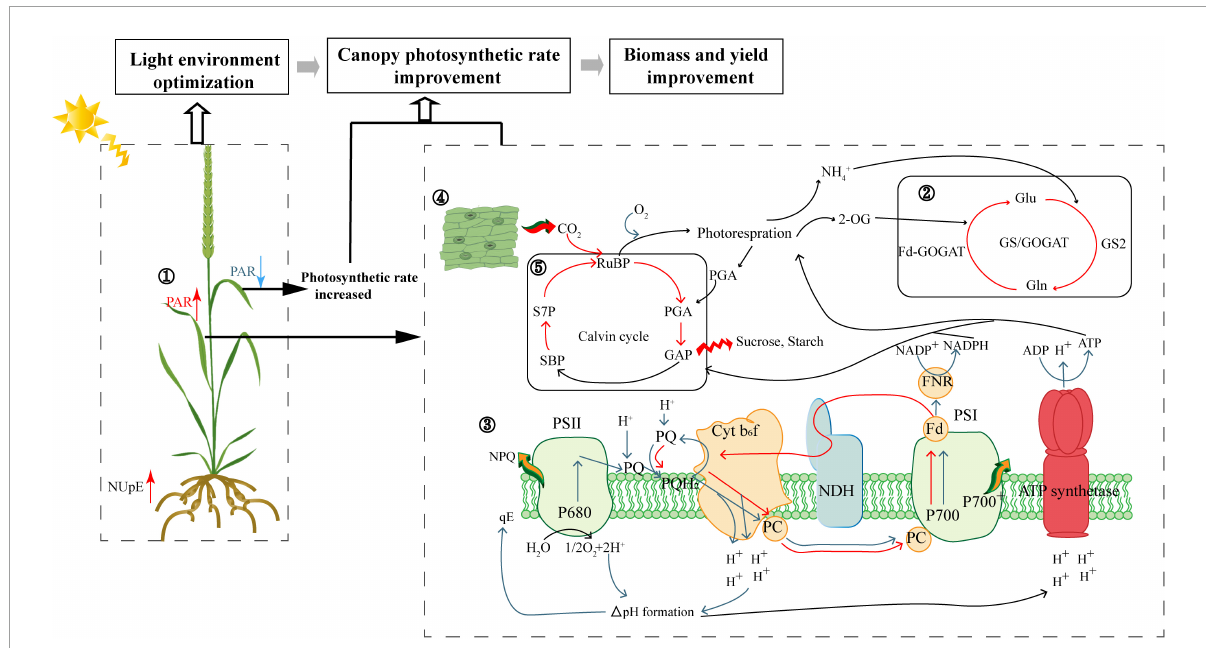
FIGURE9 The proposed model for the molecular mechanism by which optimized canopy light distribution (CLD) enhances light use efficiency. Optimized CLD increases the leaf nitrogen concentration and changes the leaf nitrogen allocation. The light allocation of penultimate leaves between photosystems was optimized by decreasing the abundance of photosystem II (PS?) light-harvesting proteins and the variety of PSII subunits and increasing the abundance of photosystem I (PSI) light-harvesting proteins. Meanwhile, linear and cyclic electron transport were coordinated. Changes in stomatal characteristics increased CO 2 concentration in leaves. With the up-regulated expression of carbon fixation enzymes, soluble sugar accumulation was promoted, facilitating the transport of assimilates to the developing grains and increasing photosynthetically active radiation (PAR)–use efficiency (PUE) and yield. Panel (cid:172) is the optimized direction of CLD. Panel (cid:173) is the nitrogen assimilation process. Panel (cid:174) is the photosynthetic electron transport chain, where the blue lines are linear electron transport and the red lines are cyclic electron transport. Panel (cid:175) is the stomatal characteristics and leaf CO 2 concentration. Panel (cid:176) is the carbon